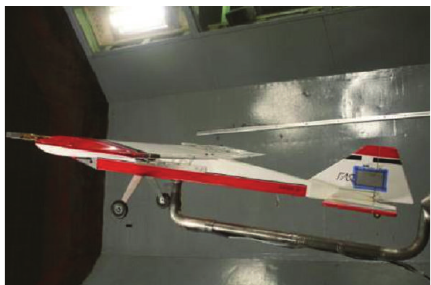
Figure 4: An UAV aircraft mounted on a forced oscillation rig